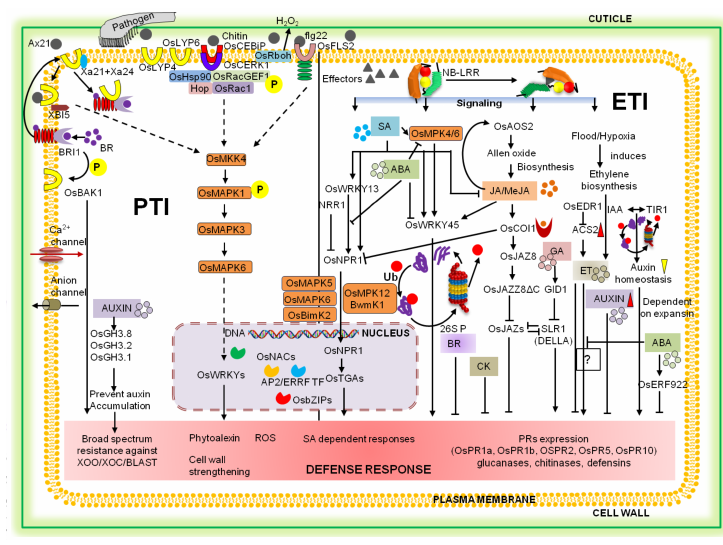
Figure 1. Schematic representation of rice defense signaling cascades. Following the pathogen perception bypattern recognition receptors(PRRs) and R proteins, the rice plant initiates the diverse set of signaling cascades at different levels (PAMP-triggered immunity (PTI), left side and ETI, right side) involving numerous signal molecules, viz. ROS, NO, MAPKs, CDPKs, phytohormones to trade-off the pathogen invasion. In case of PTI, the host cell recognizes the common molecular pattern associated with most of the pathogens using PRRs (OsLYP6, OsFLS2, OsCEBiP, OsCERK1, Xa21, Xa24) and initiates MAPK kinase cascades (OsMKK4–OsMAPK6) that actually activate host defense responses via various transcriptional regulatory factors (OsWRKYs, OsNACs, OsNPR1, OsTGAs, OsbZIPs). However, PTI is suppressed by pathogen effectors, where they are encountered by the resistance genes ( NBS - LRRs ) that lead signaling to activate defense responses through phytohormonal activities. The archetypical defense pathways, SA and JA/ET pathways, mainly antagonistic to each other, are responsible for resistance against biotrophs and necrotrophs, respectively. The defense response includes production of PR proteins (glucanases, chitinases, defensins), production of ROS and NO, change in ion fluxes (Ca 2+ ), cell wall strengthening (callose and lignin deposition) to confine the pathogen dissemination and disease development. GA, CK and Auxin act as negative regulators of plant innate immunity. BR prompts or suppresses disease susceptibility based on pathogen lifestyle or colonization. Furthermore, abscisic acid (ABA), well-known in abiotic stress tolerance, plays an ambiguous role, i.e., is both a positive and negative regulator of rice disease resistance based on the type and stage of infection; however, it predominantly actsas a negative regulator. The abbreviations used in the figure above represent viz. SA-salicylic acid; JA-Jasmonic acid, MeJA-Methyl Jasmonate; GB-Gibberellins, BR-Brassinosteroid; ET-Ethylene, CK-Cytokinin; ABA-Abscisic Acid, OsNPR1-Non-expressor of PR1 (NH1, NPR1 homolog1); OsCOI1-Coronatine Insensitive1 (JA receptor); OsJAZ8-Jasmonate ZIM domain protein, HPL3-Hydroperoxide lyase; ACS2-Enzyme for ET biosynthesis (ACC Synthase); OsEDR1-Enhanced Disease resistance 1 (TR1-like kinase); SLR1-slender rice1 (DELLA protein); GID1-encodes GA receptor; BRI1-BR Insensitive 1 (RLK) BR receptor. There is extensive crosstalk between various phytohormones in rice against biotic